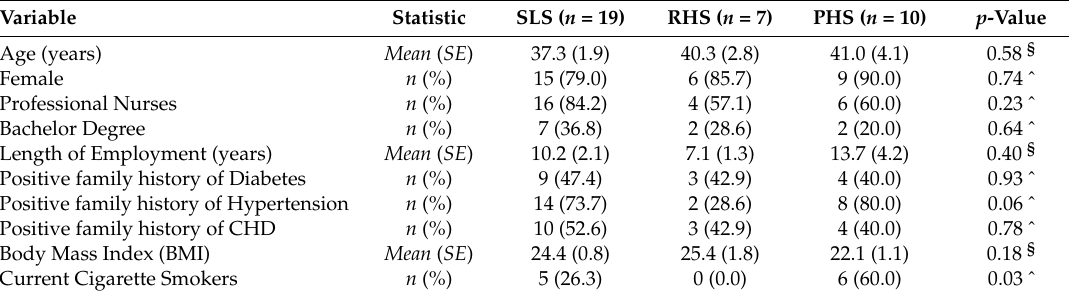
Table 1. Demographic and clinical characteristics in the investigated three strain categories: stable low strain (SLS); recently high strain (RHS) and prolonged high strain (PHS). Variable